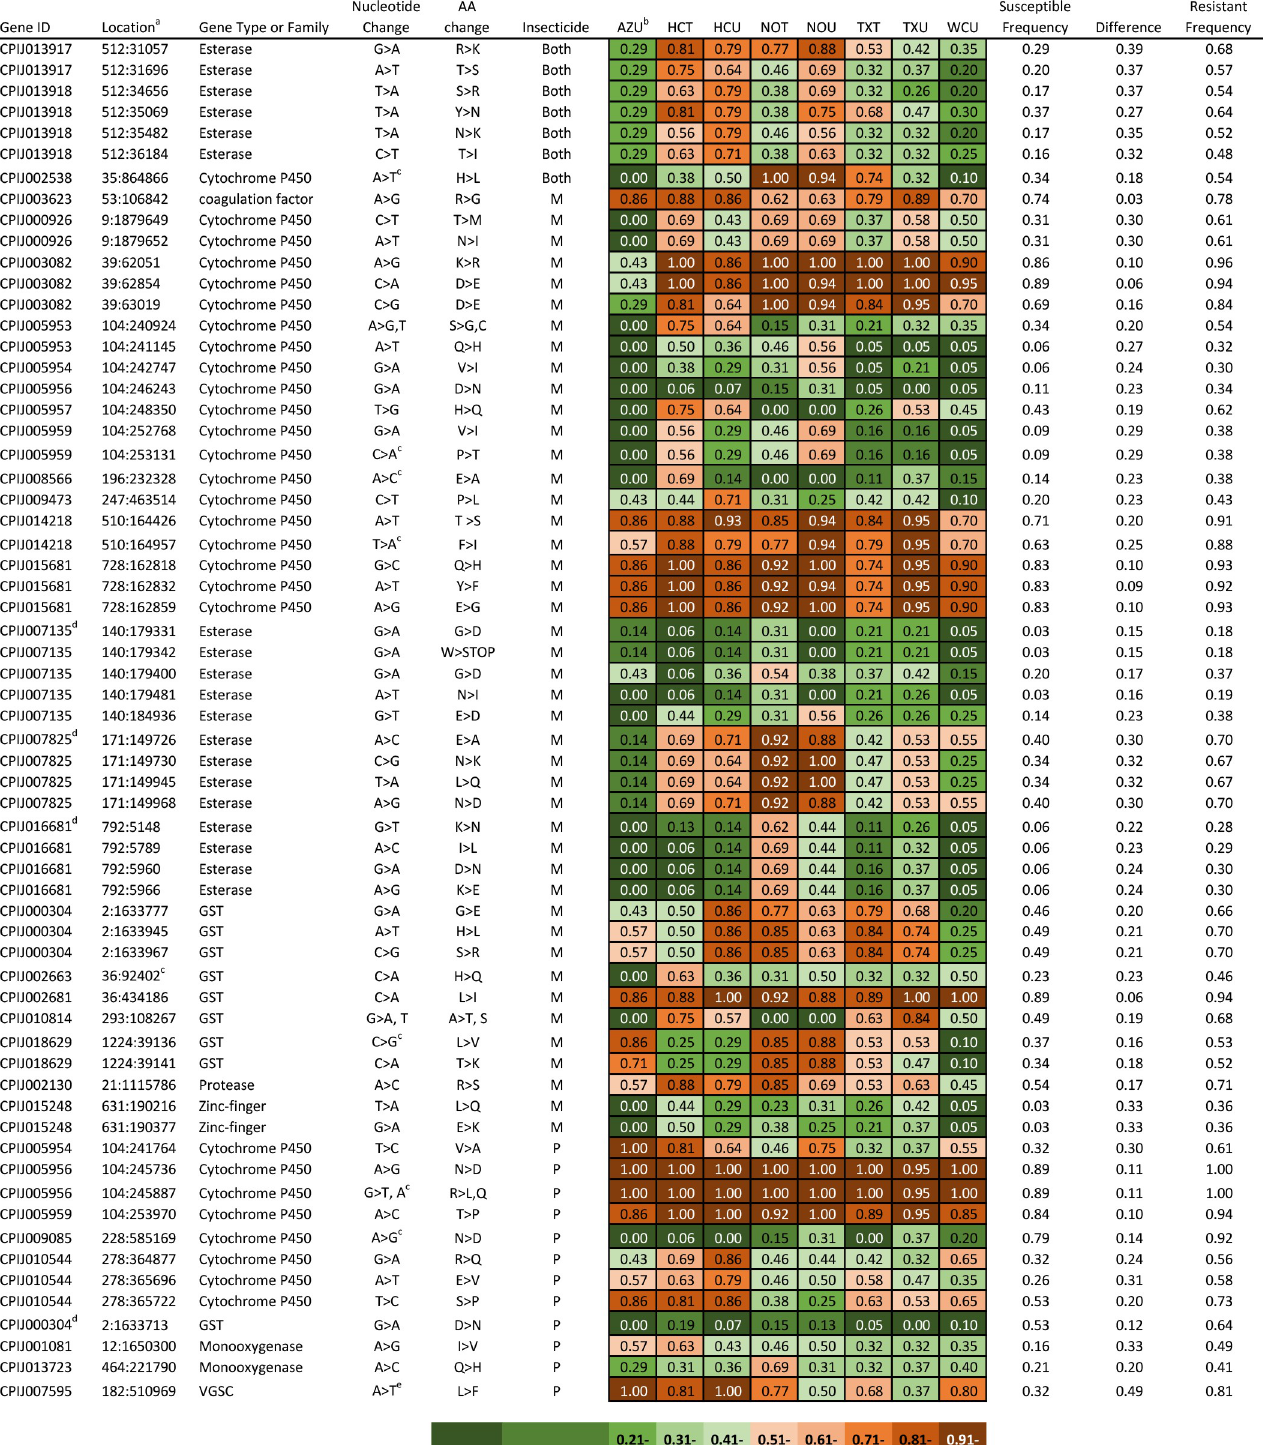
PLOS ONE | https://doi.org/10.1371/journal.pone.0218397 July 3,